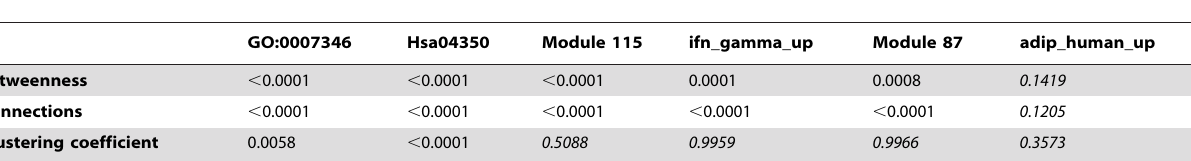
Table 5. Significance (p-value) of the network parameters measured for the different network properties in the different